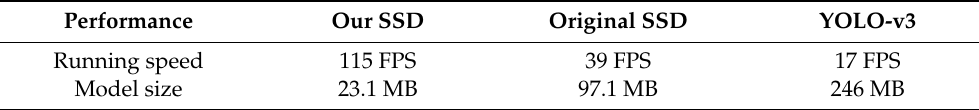
Table 6. Comparison of running speed and model